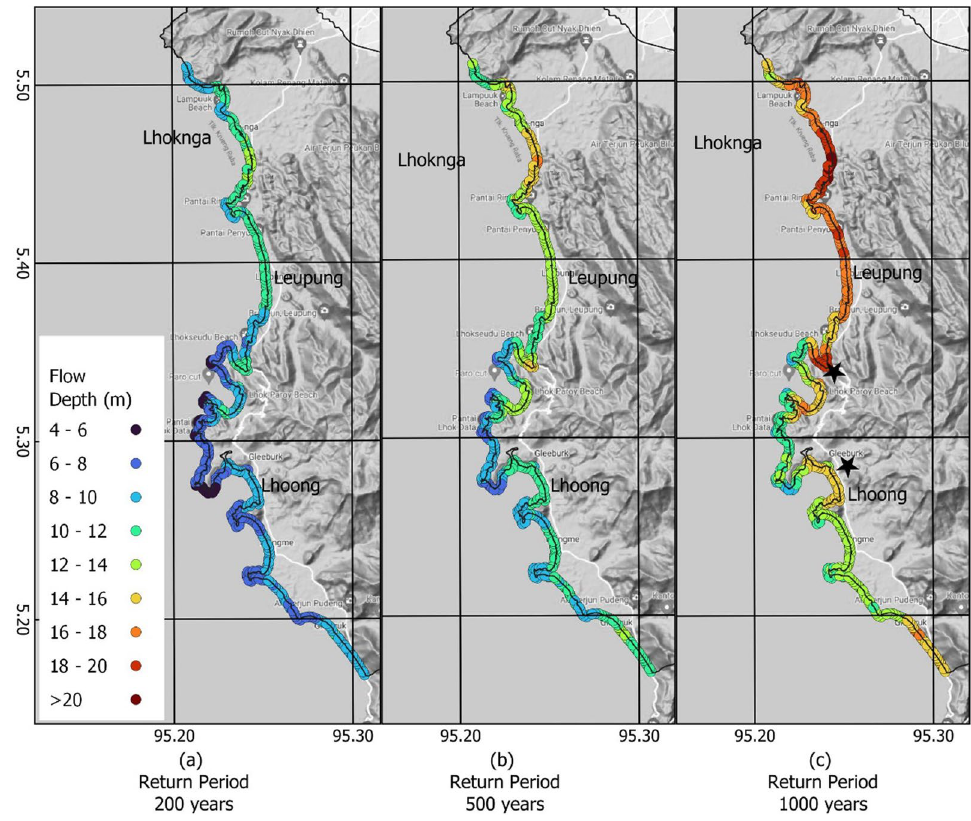
Fig. 10 Tsunami Hazard Map for 200, 400, and 1000-year return periods at the observation